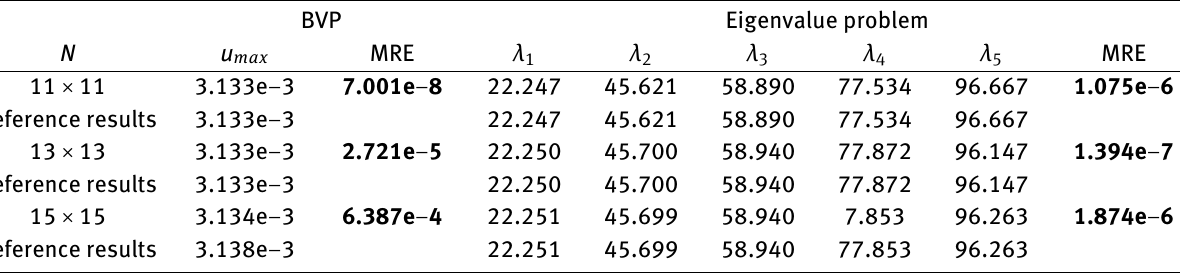
Table 7: The results from solving the biharmonic problems on the triangular domain with corner cut-out. The boundary conditions given by Eq. (29) implemented using strategy 1.